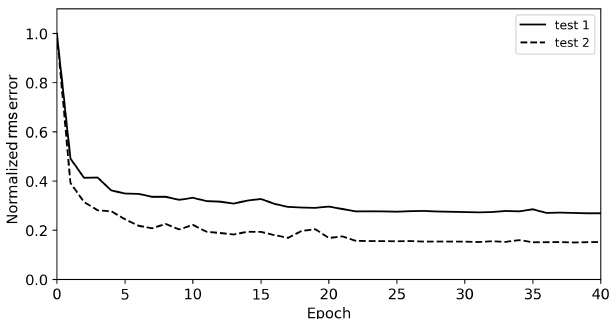
Figure 15. Normalized rms error between the ground truth and de- noised result of the first (solid) and second (dashed)